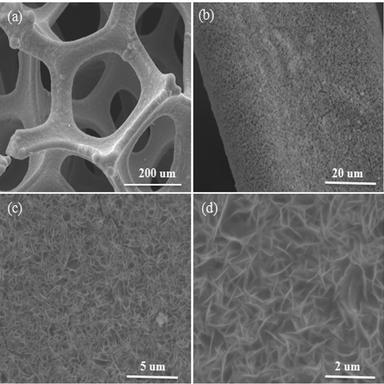
SEM image of as grown Co(OH)2 nanosheet arrays at at different magnifications.